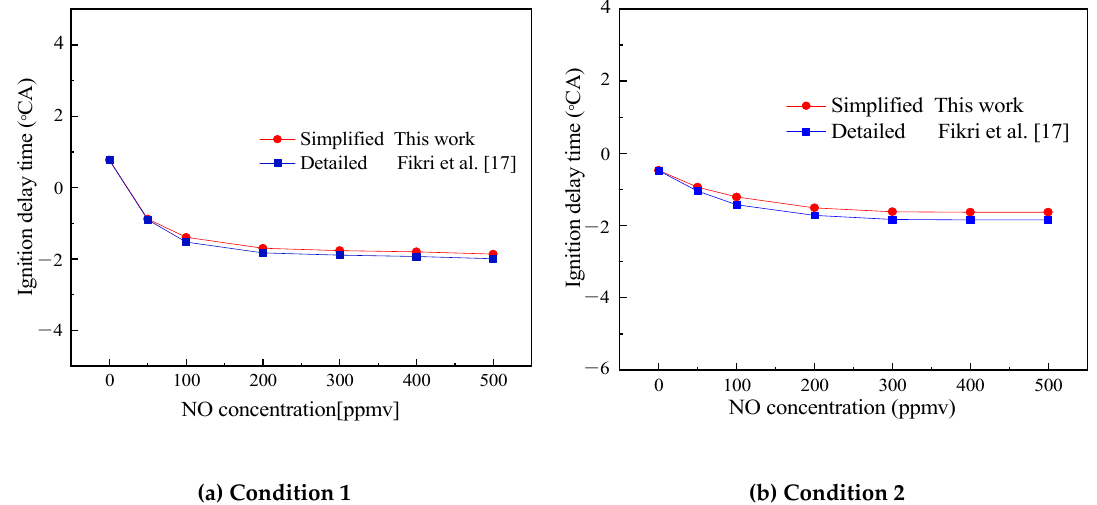
Figure 14. Comparison of simulated and experimental values of the ignition delay time of Surrogate D with the concentration of NO added. ( a ) Condition 1, ϕ = 0.25, 4 atm and 600 K; ( b ) Condition 2, ϕ = 0.25, 2 atm and 800 K.